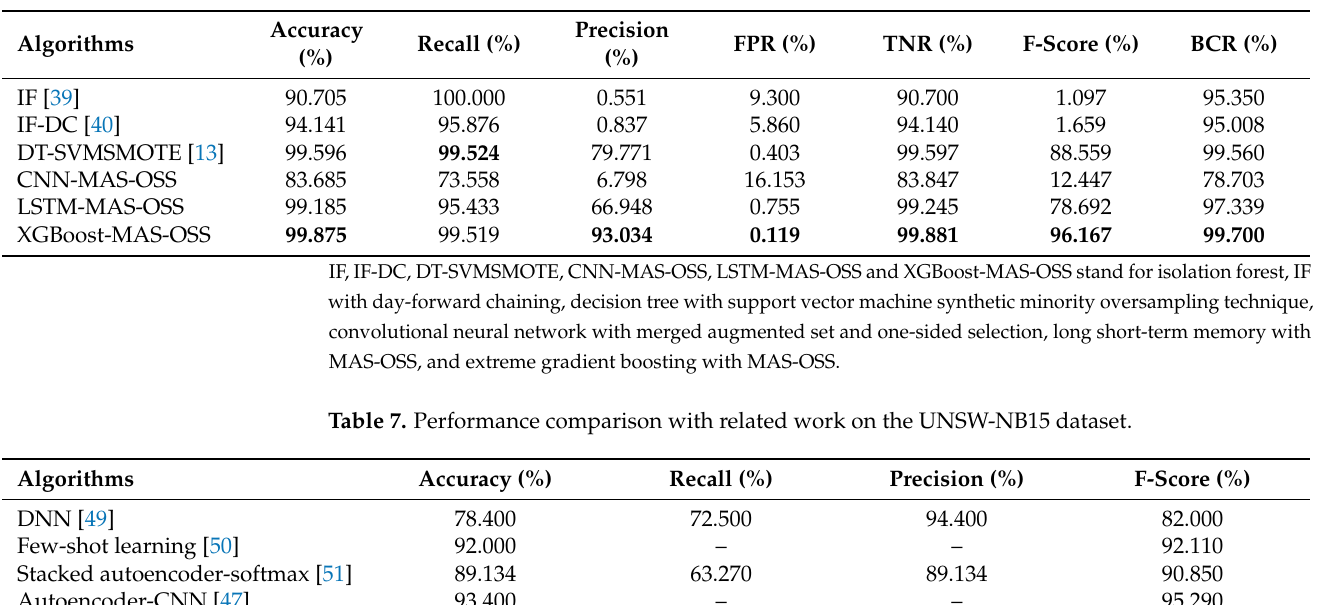
Table 6. Performance comparison with related work on the enterprise dataset.